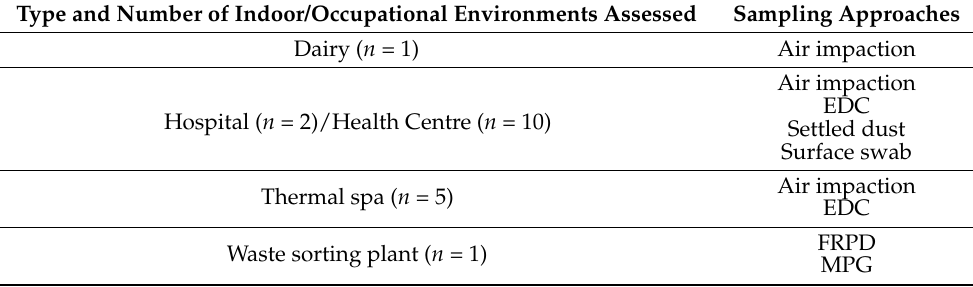
Table 1. Indoor and occupational environments assessed and applied sampling approaches. Type and Number of Indoor/Occupational Environments Assessed Sampling